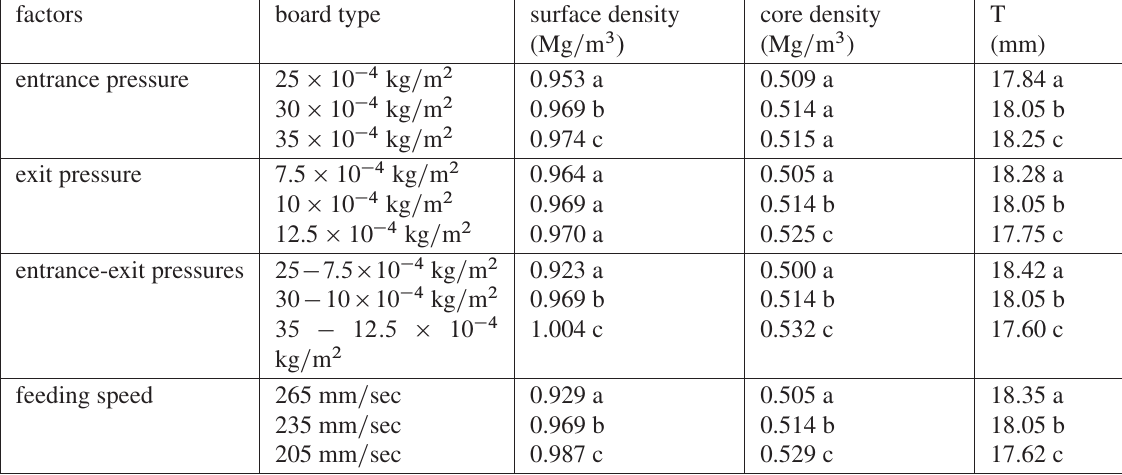
Table 3. Results of statistical analysis own to effects of entrance and exit pressures, and feeding speed of the continuous press on the density profile and thickness of the test